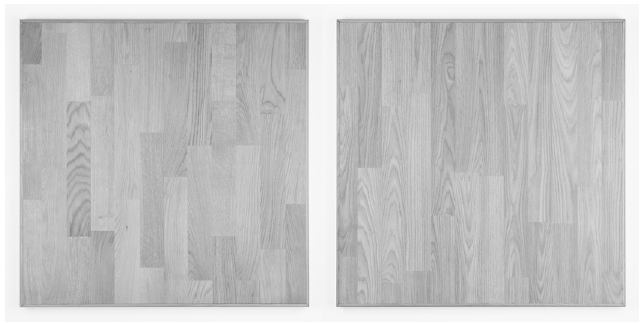
Figure 1. Framed floor pieces. ( Left ) oak hardwood (floor A); ( right ) laminate with oak optic (floor B).